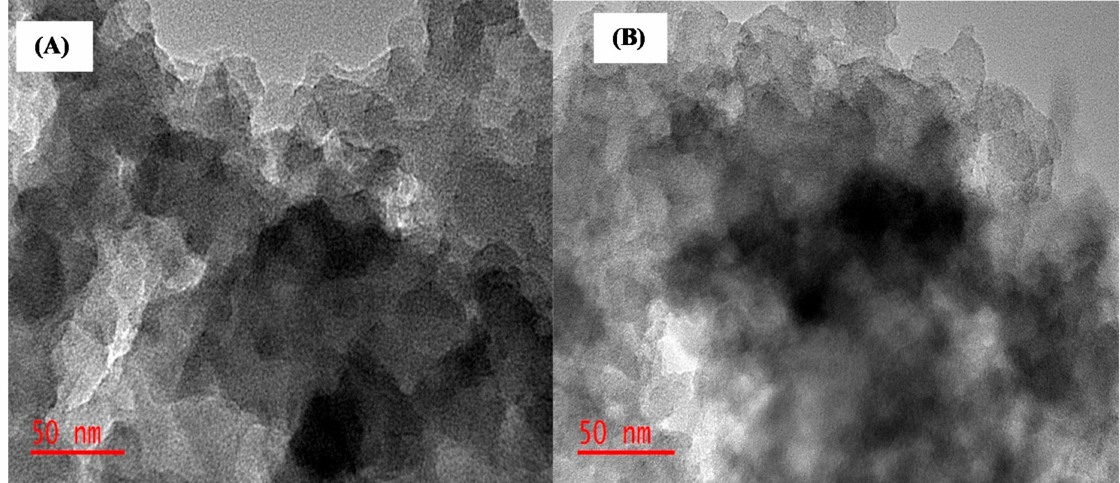
Figure 4. TEM images of ( A ) ACT-MIP and ( B )